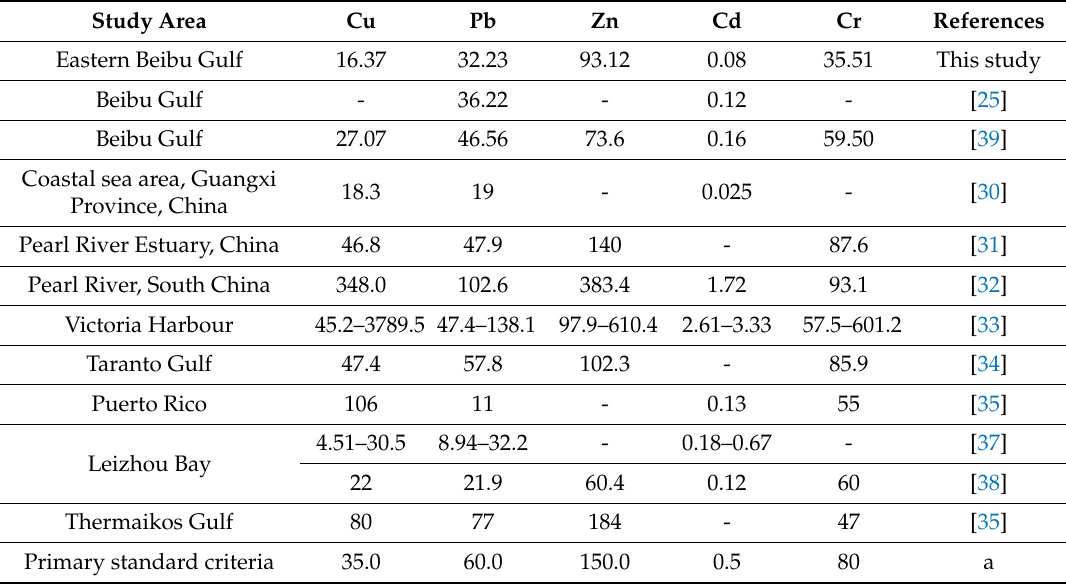
Table 2. Comparison of the concentrations of heavy metals in the study area with values from the literature (unit: